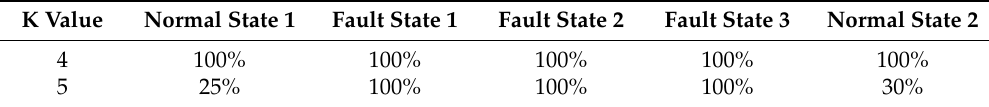
Table 2. Accuracy of K-means with K = 4 and K = 5 in fault